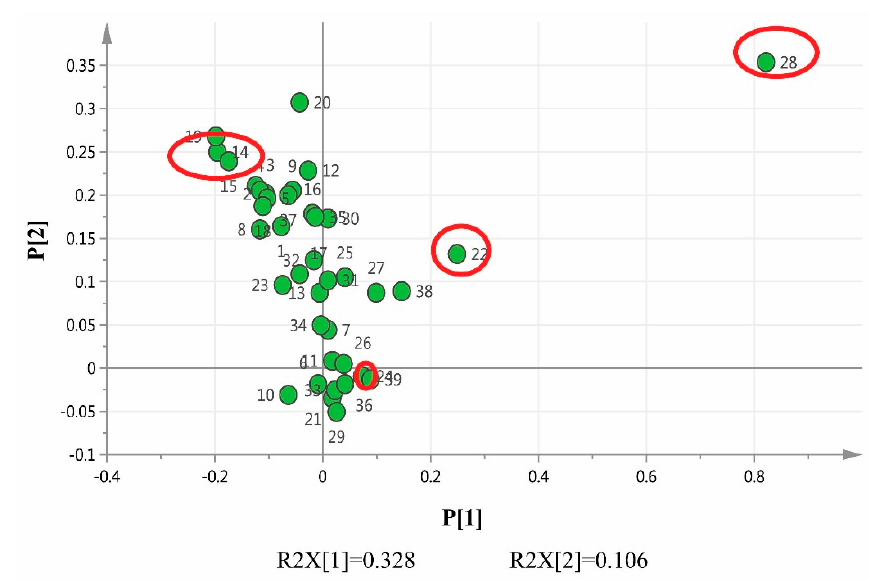
Figure 4. The loading plot for the common peaks, 4-methoxy-5-hydroxycanthin-6-one (14), andrographolide (15), neoandrographolide (22), rosmarinic acid (24) and dehydroandrographolide (28).